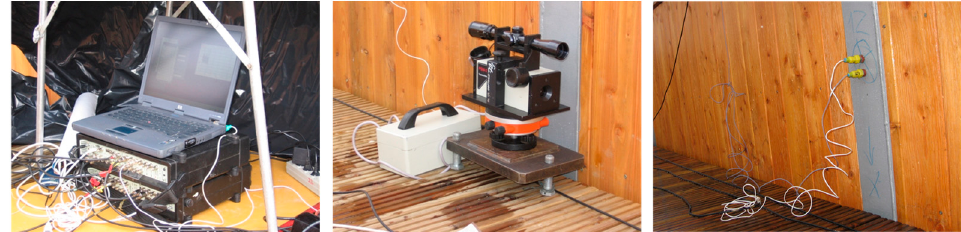
Figure 8. Measurement devices (Bruel & Kjaer amplifiers, Noptel OY PSM200 laser device and Endevco accelerometers).